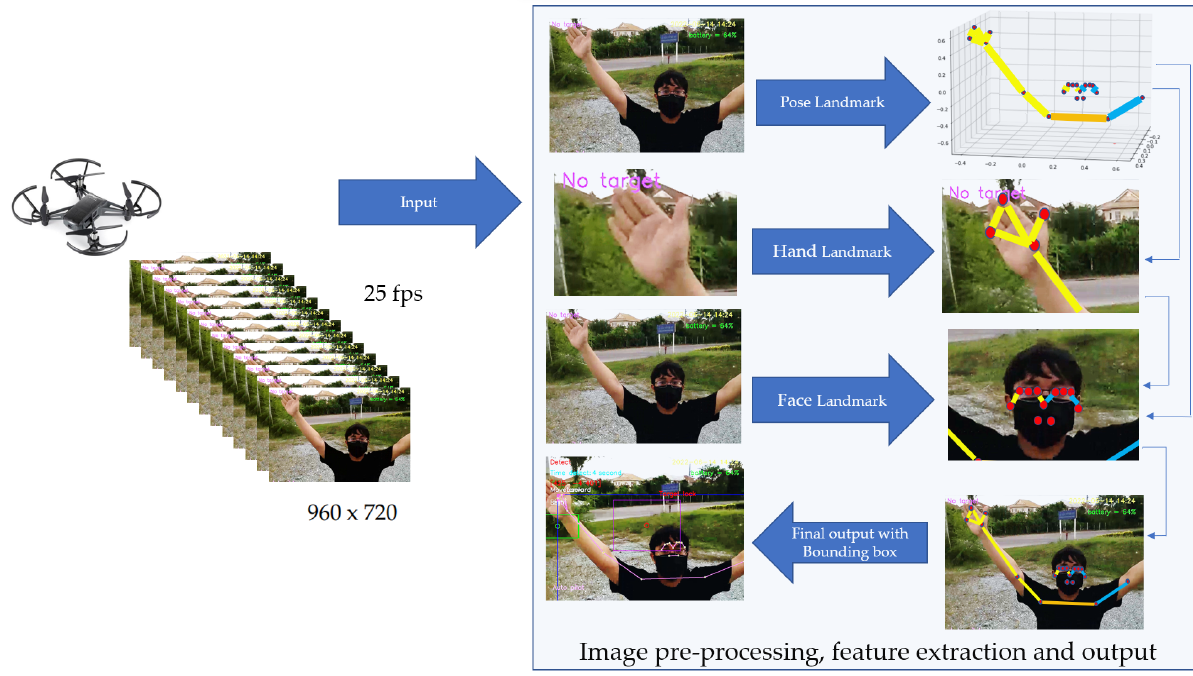
Figure 5. Image pre-processing, feature extraction, and